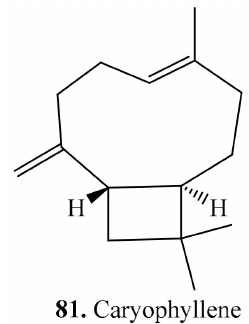
Figure 9. Structure of the sesquiterpenoid isolated from